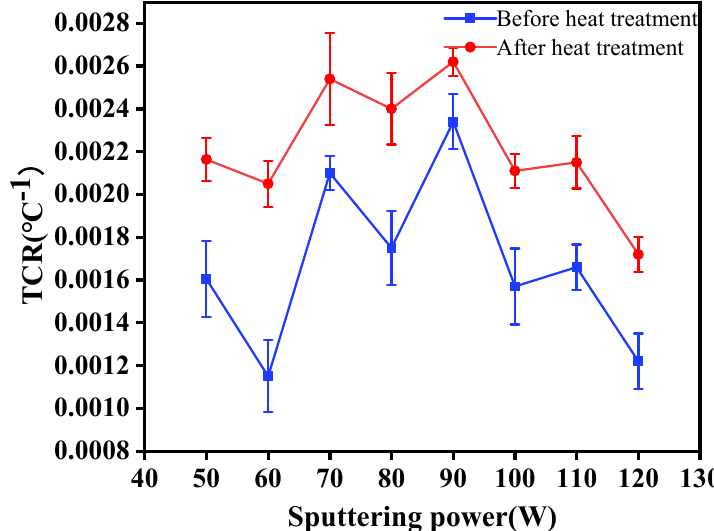
Figure 4. TCR of temperature sensing layers at specific sputtering powers.